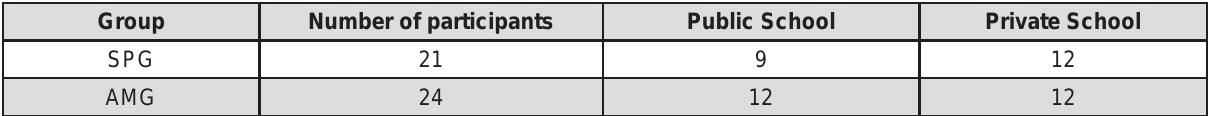
Figure 1- Sample distribution according to group and type of school. SPG=São Paulo group; AMG=Amazonas